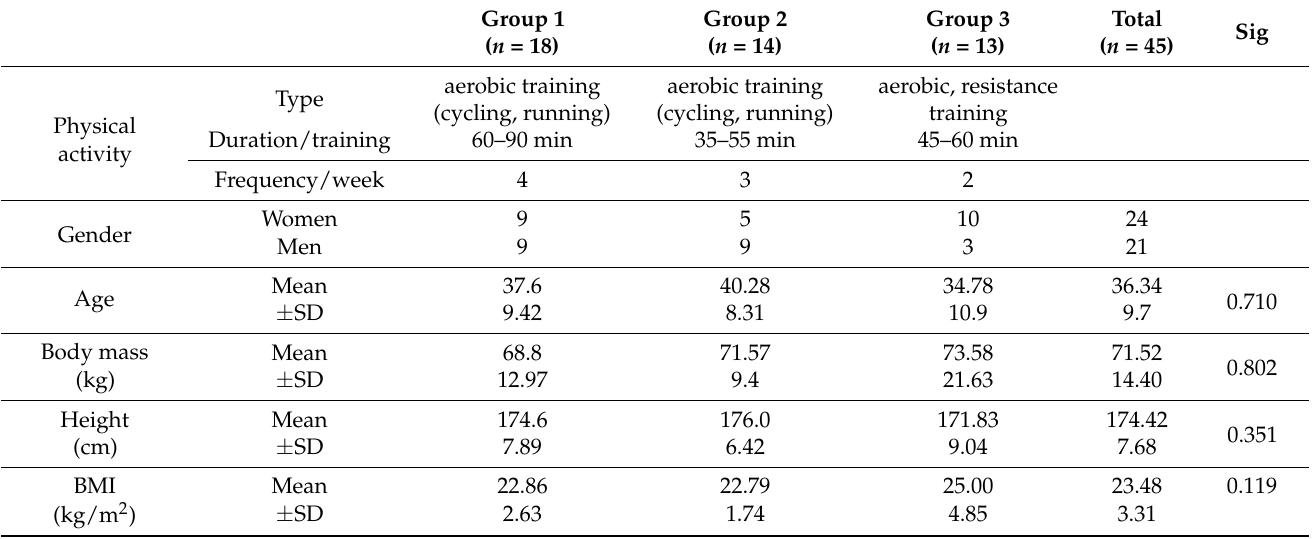
Table 1. The demographic characteristics of the